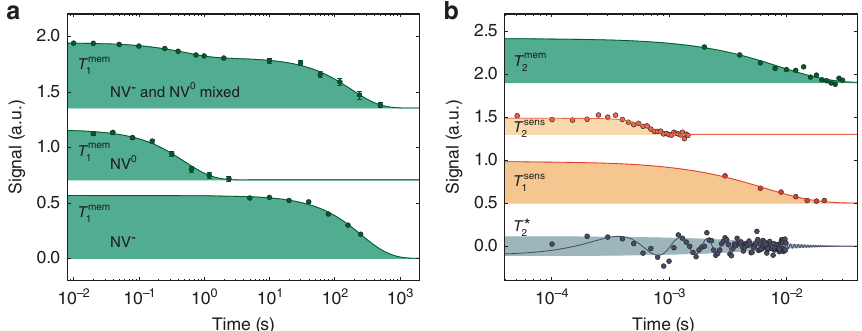
lifetime at 1.35 T. The data 1 = 688 ± 31 μ s) and longitudinal relaxation ( T sens 1 2